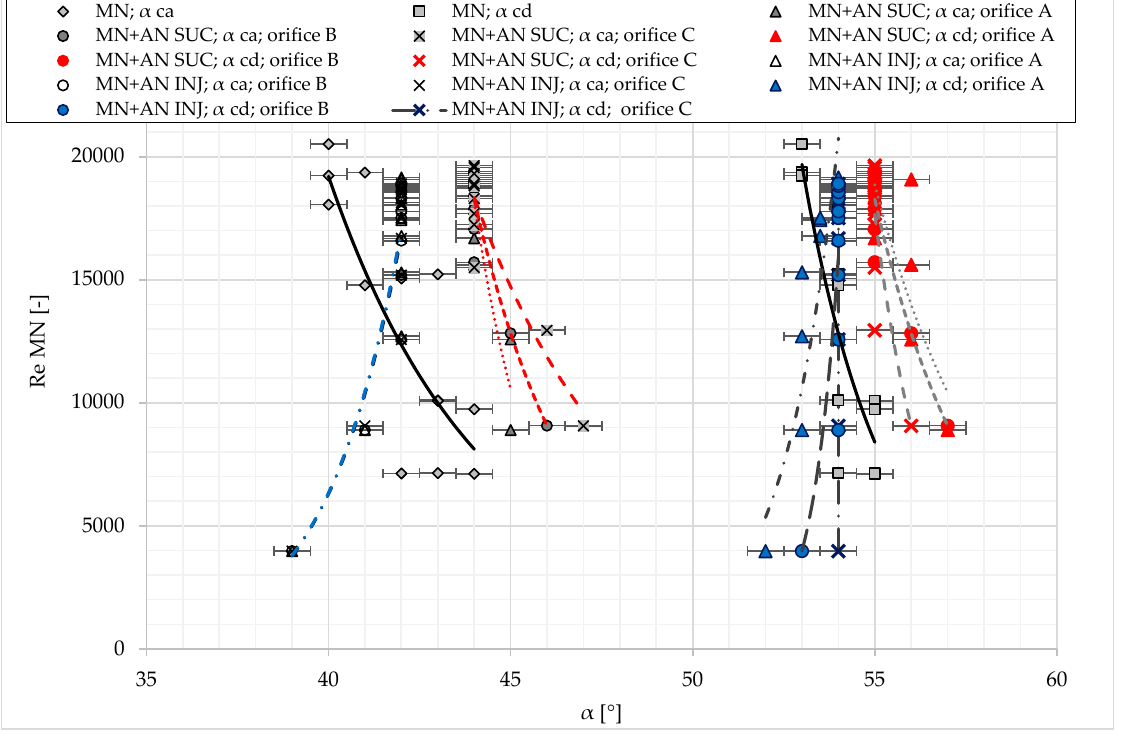
Figure 9. Correlations between the critical angle of separation α cd and the critical angle of attachment α ca (trend lines) vs. the Reynolds number.